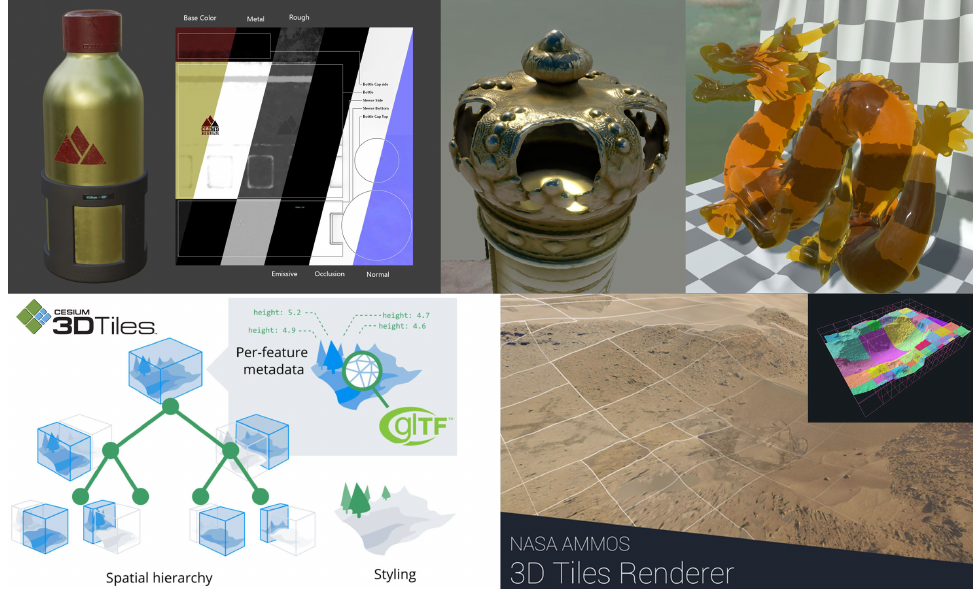
Figure 1. Top row (from left to right): water bottle sample with PBR materials from Khronos glTF samples, detail of a public domain CC0 model from Malopolska’s Virtual Museums (https: //sketchfab.com/WirtualneMuzeaMalopolski, accessed on 22 November 2021) and support for real-time volumetric refraction and absorption (sample glTF model “Dragon” by Khronos). Bottom row: Cesium 3D Tiles specification and NASA AMMOS open-source 3D Tiles